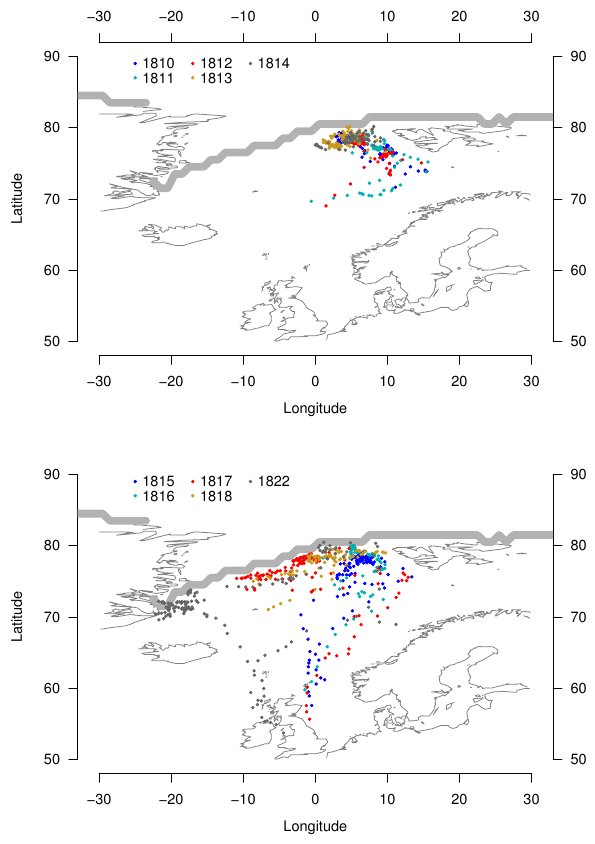
Fig. 1. Routes of William Scoresby’s whaling voyages — split into two panels to avoid muddying the figure. The broad grey line is the Septembersea-iceedgefromRayneretal.(2003),medianvalueover1979–2004.